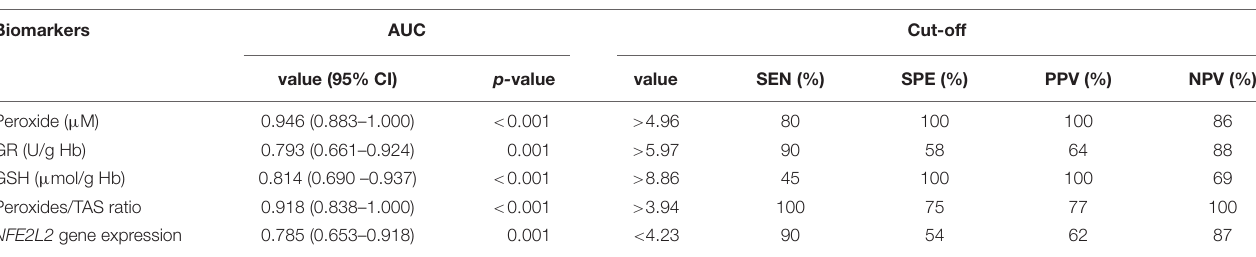
TABLE 3 | Significant oxidative stress parameters as ESA response biomarker in myelodysplastic syndrome.